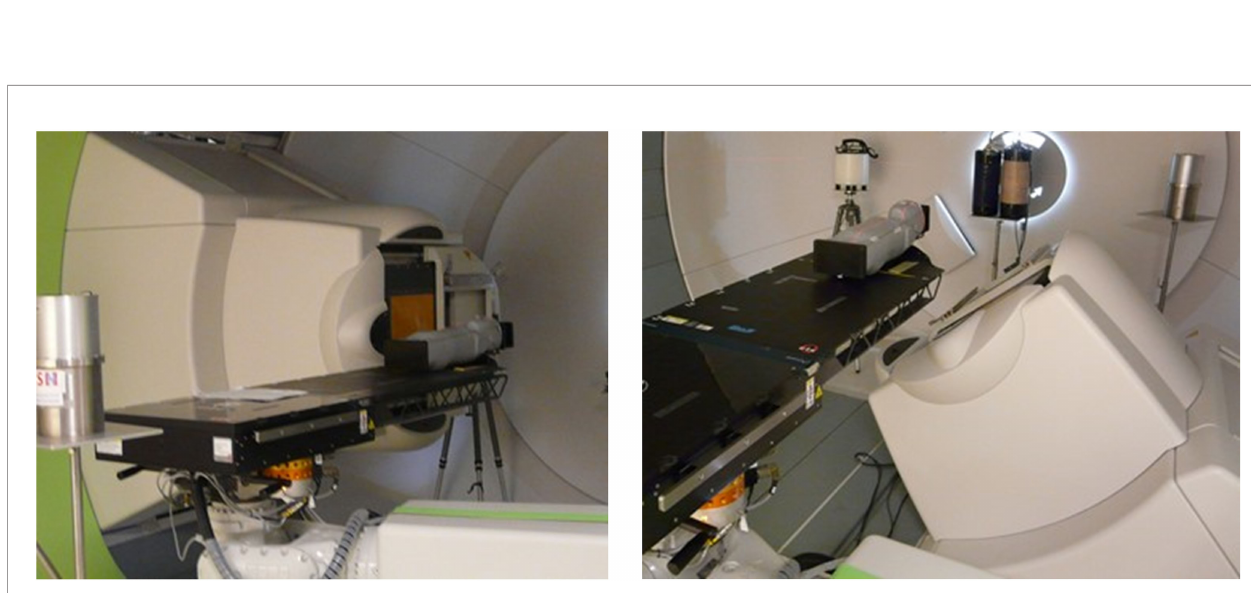
FIGURE 2 | Schematic view of measurement positions around the 10-year-old pediatric phantom (left), and two gantry positions (right) (24).